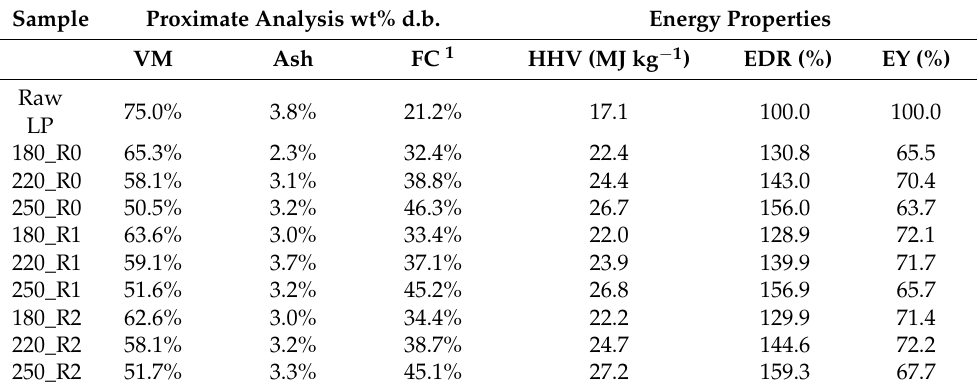
Table 2. Proximate analysis and energy properties of raw LP and hydrochars. Proximate analysis performed in duplicate; average values showed (Er% ≤ 2.9%). Higher heating values (HHVs) average of two measurements, Er% ≤